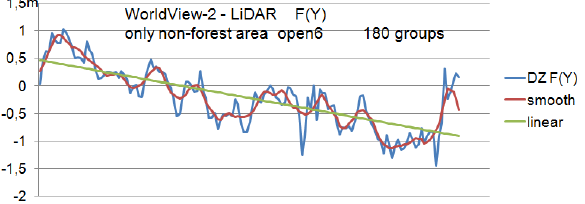
Figure 20. Systematic discrepancies of WorldView-2 DSM, bias corrected by affine transformation, computed for 180 discrepancies in non-forest areas, mask open6